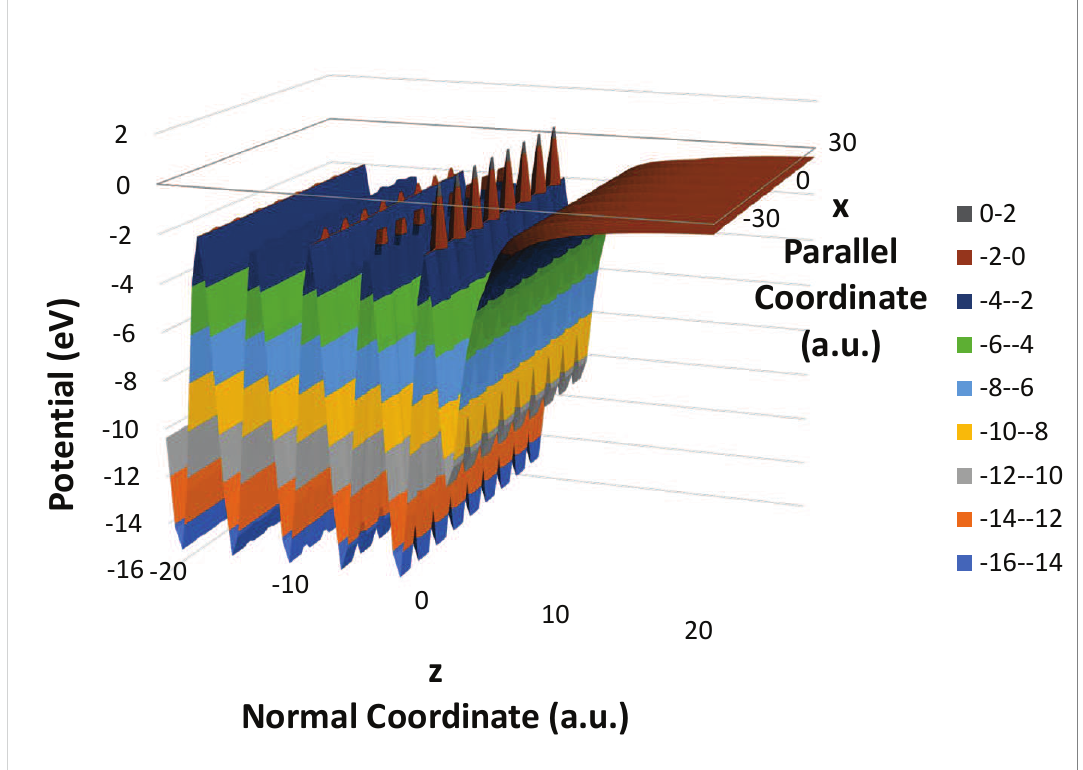
Figure 3. Schematic of two-dimensional vicinal stepped potential on flat Pd(111) with d being five atomic layers developed using the Kroenig-Penny (KP) potential in Figure 1 which is super-imposed on the one-dimensional parametric potential of Pd(111) [32,33] in Figure 2 (bottom panel). The KP potential is attenuated going far from the precursor flat surface both towards the bulk and the vacuum. To aid visualization, the peaks of the KP potential are scaled by a factor of 2.8 in the figure. Note that the maximum vicinal peaks occur at z =